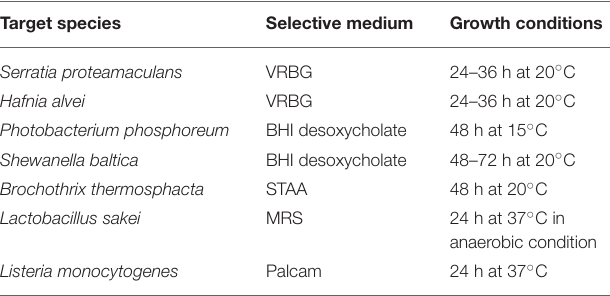
TABLE 2 | Targets selective culture media and growth